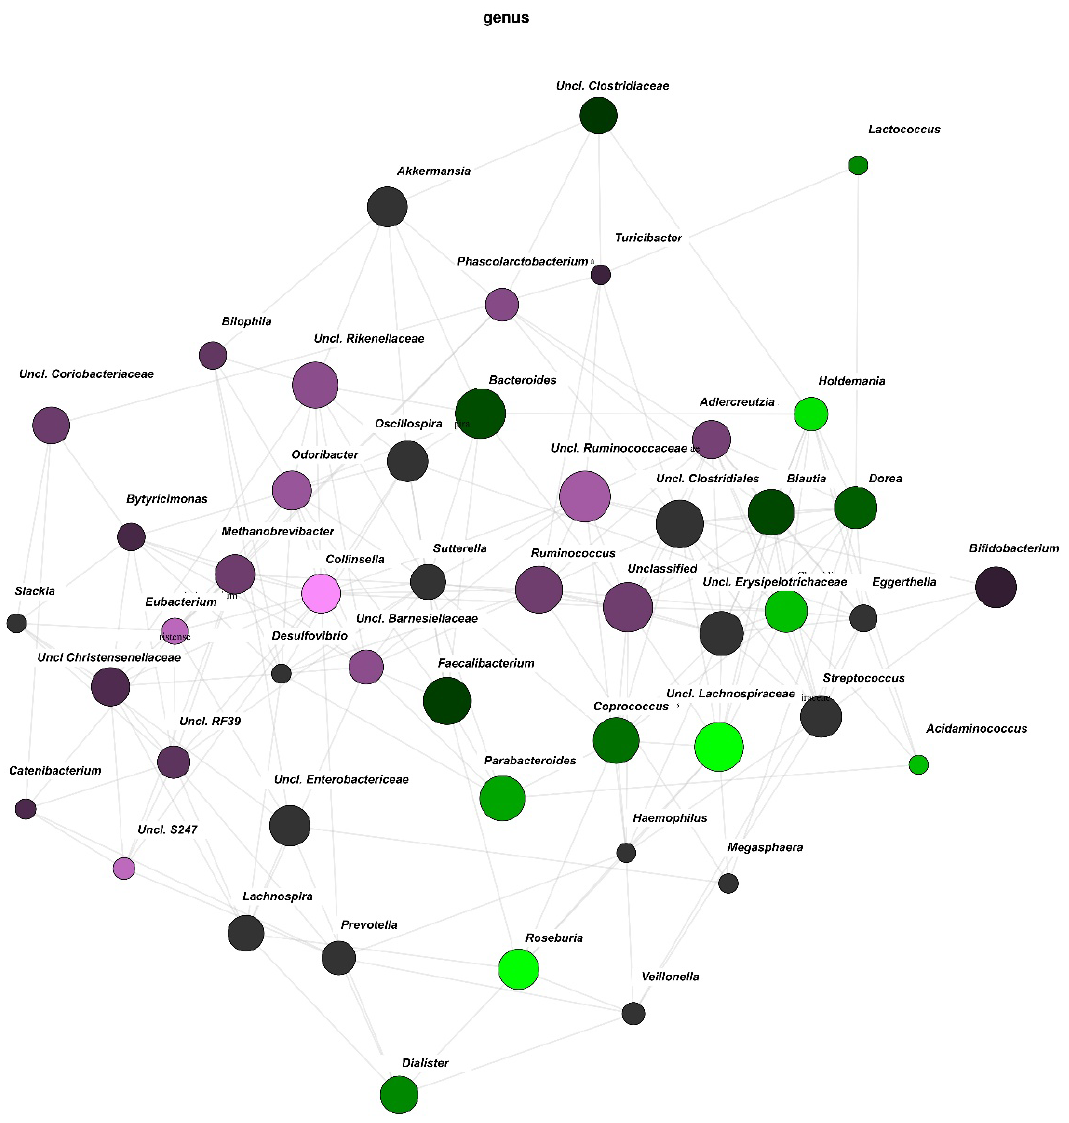
Figure 3. Network Analysis. The relative brightness of the nodes indicates the significance level of their association. Genera associated with an omnivorous diet are displayed in more pink/purple and those associated with a vegetarian diet are displayed in green.